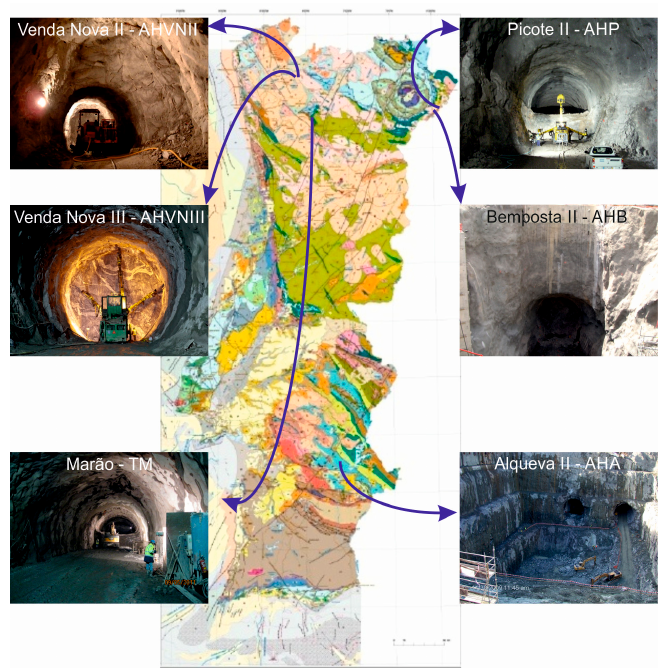
Figure 2. Infographics of the six case studies superimposed on an image of the geological map of Portugal (1:1,000,000) (adapted from [30]).